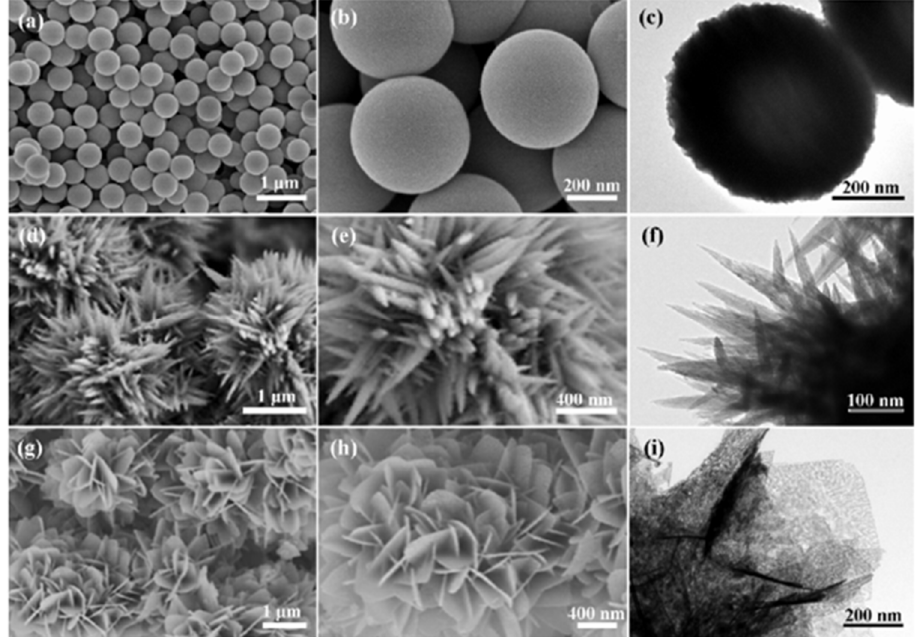
Figure 23. Scanning electron microscope (SEM) and transmission electron microscope (TEM) images of the SnO 2 samples with different morphologies: ( a – c ) solid spheres (S0), ( d – f ) nano-needle assem- bled nano-urchins (S1), ( g – i ) nanosheet-assembled nanoflowers (S2) [106]. Copyright (2019), with permission from Elsevier.